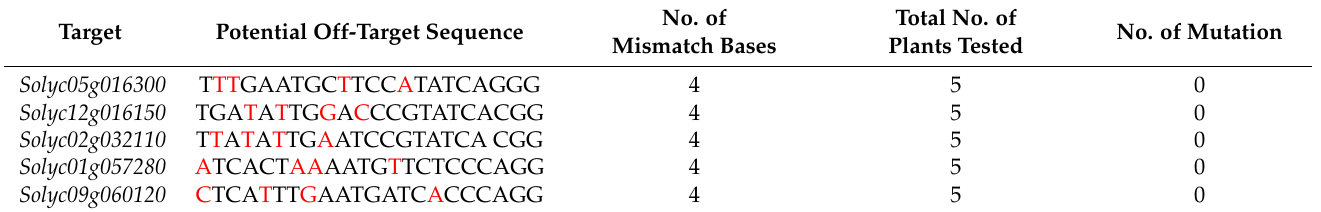
Table 3. Sanger sequencing results of potential off-targets of XSP10 and SlSAMT in GE 0 CRELs. Target Potential Off-Target